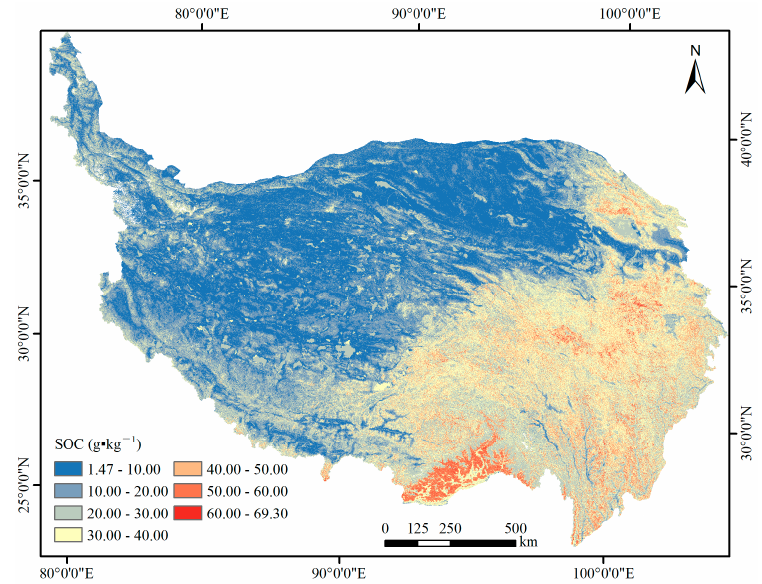
Figure 6. Spatial variability of SOC in the QTP.